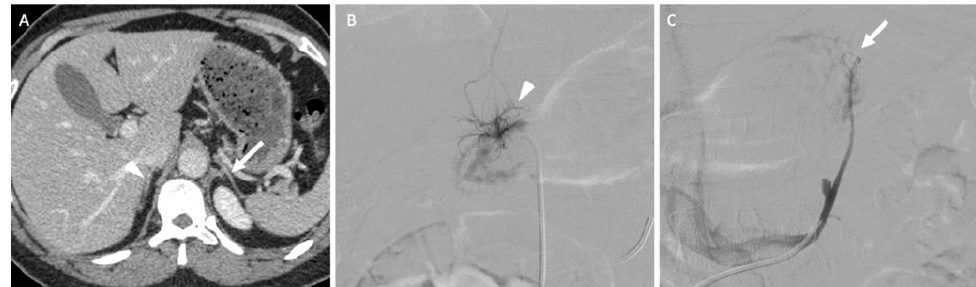
Figure 9. A 45-year-old woman with primary hyperaldosteronism with normal adrenal glands on computed tomography (CT) and MRI who underwent bilateral adrenal vein sampling. ( A ) The CT image in the axial plane obtained 70 s after intravenous administration of iodinated contrast material shows two thin adrenal glands (the arrow indicates the left adrenal gland; the arrowhead indicates the right adrenal gland) without a nodular portion. ( B ) The digital subtracted angiographic image shows selective catheterization of the right adrenal vein (arrowhead) using a 5-F Shepherd hook catheter. ( C ) The digital subtracted angiographic image shows selective catheterization of the left adrenal vein (arrow) using a 5-F left renal catheter. Blood sample analysis confirmed elevated aldosterone secretion from the right adrenal gland. The patient underwent right adrenalectomy, and her aldosterone serum level returned to normal values.